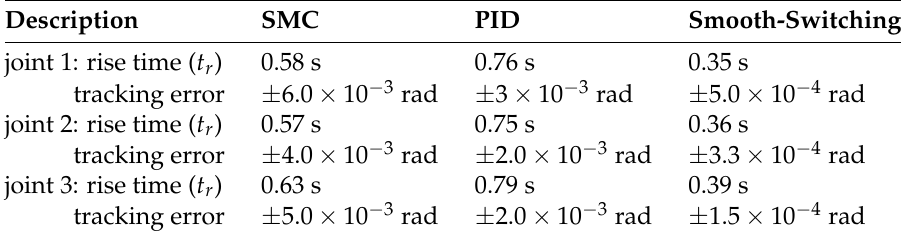
Table 3. Performance indexes of SMC, PID and smooth-switching with q d = 1 + 0.5sin ( π t ) .